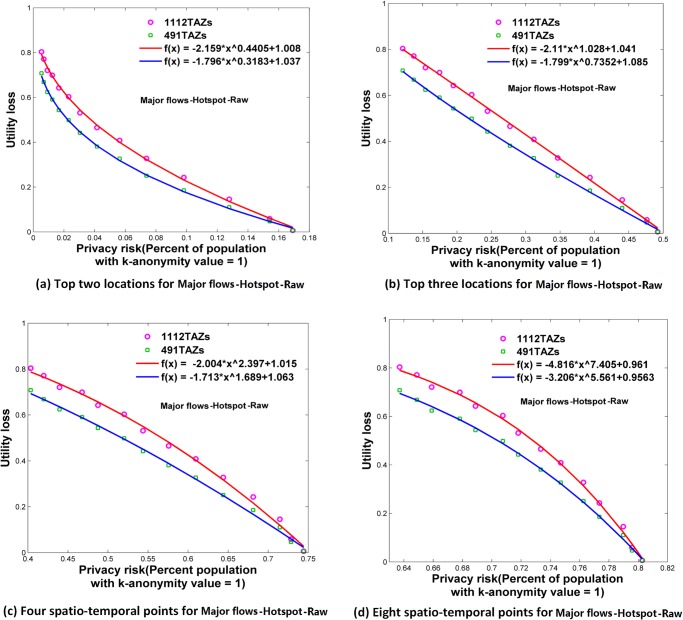
Relationships between privacy risk and data utility using Major flows-Hotspot-Raw.(a) Top two locations. (b) Top three locations. (c) Four spatio-temporal points. (d) Eight spatio-temporal points.